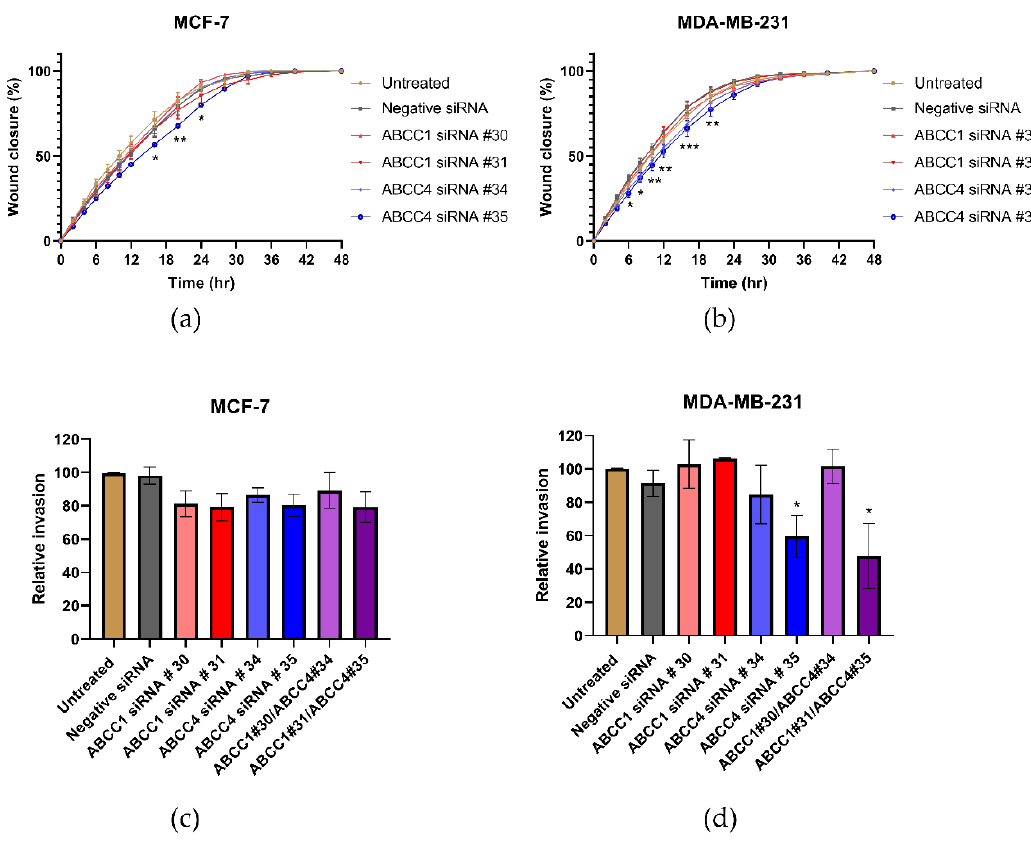
Figure 7. siRNA knockdown of ABCC4 affects the migration of breast cancer cells. ( a , b ) Migration of breast cancer cells following the siRNA-mediated knockdown of ABCC1 or ABCC4 was analyzed using a scratch assay. Data are mean ± sem, n ≥ 9. ( c , d ) Migration of breast cancer cells following the siRNA-mediated knockdown of ABCC1 or ABCC4 was also investigated using a cellular invasion assay. Data are mean ± sem, n ≥ 3. Data were analyzed by an ANOVA with a Dunnett’s post hoc test. * p < 0.05, ** p < 0.01, and *** p < 0.001 significantly lower than with the negative siRNA treatment.